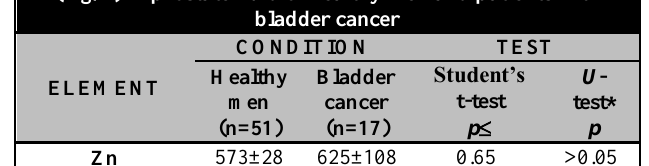
Comparison of mean values (M  SEM) of Zn concentration